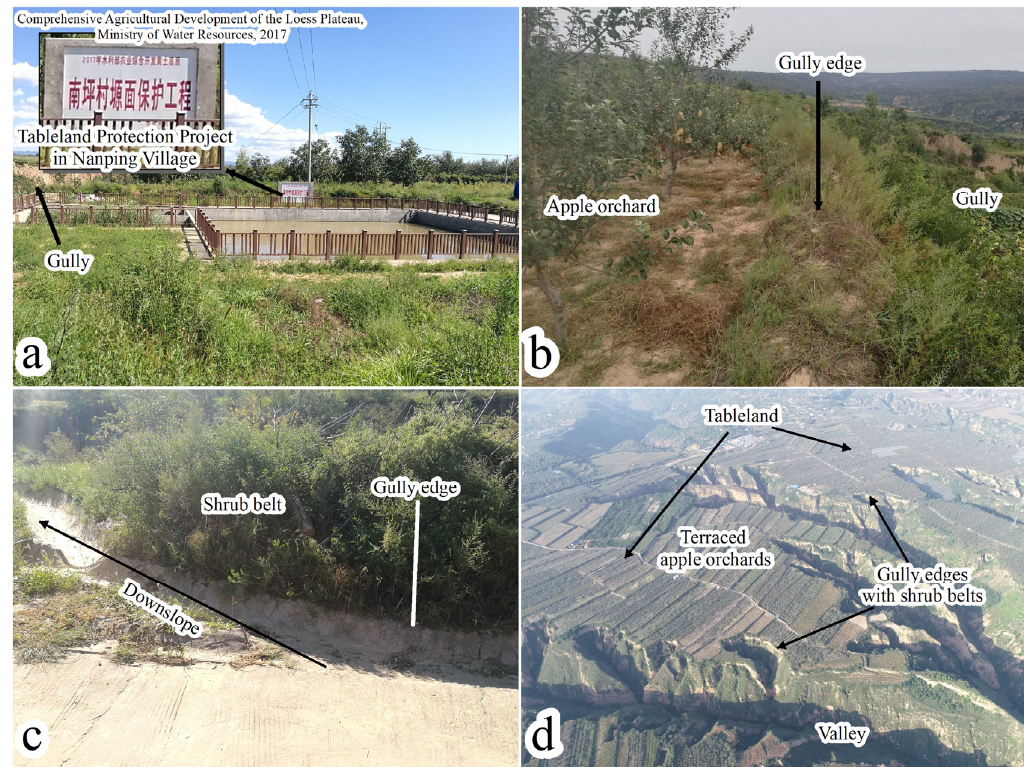
Figure 8. Some measures of the Grain for Green Project (GFGP); and Gully Stabilization and Tableland Protection Project (GSTP) were implemented in the study area. ( a ) A reservoir (20 × 20 m) to hold back the direct runoff into gullies, ( b ) the tableland boundary was ridged with a shrub belt to reduce direct runoff into gullies. ( c ) The human-made loessial ridge and shrub belt at the gully edges lead runoff downslope, reducing direct runoff into the gully head. ( d ) The tableland margin area was terraced and reclaimed as apple orchards, with shrub belts at the gully edges.